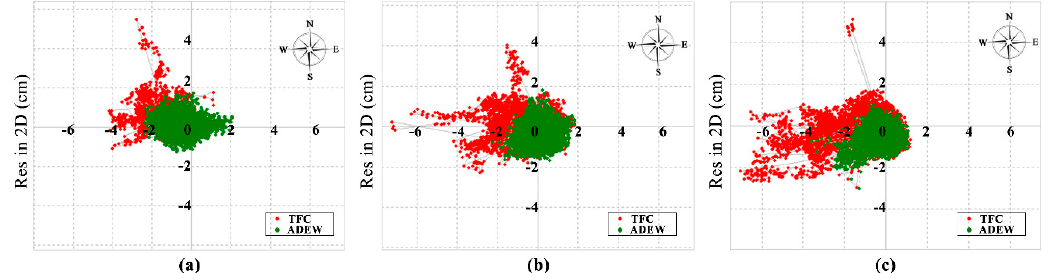
Figure 13. Deviation of the fixed coordinate time series in the horizontal direction with GNSS observations from NQ02 for three different days: ( a ) DOY 021; ( b ) DOY 045; ( c ) DOY 072.